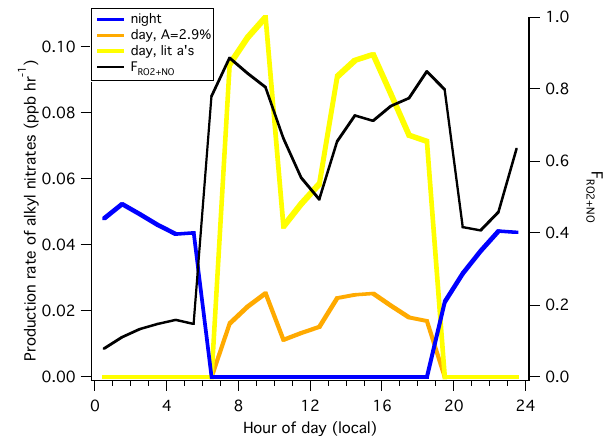
Fig. 12. Calculated rates of production of organic nitrates for daytime OH-initiated (orange/yellow) and nighttime NO 3 -initiated (blue) mechanisms. The fraction of RO 2 radicals that react with NO ( F RO , black) ranges from ≈ 40%–90% during the day. The 2 + NO daytime production of organic nitrates is calculated using the ob- served A of 2.9% (orange) and, alternately, using literature chamber organic nitrate yields of 23% for monoterpenes and 7% for MBO